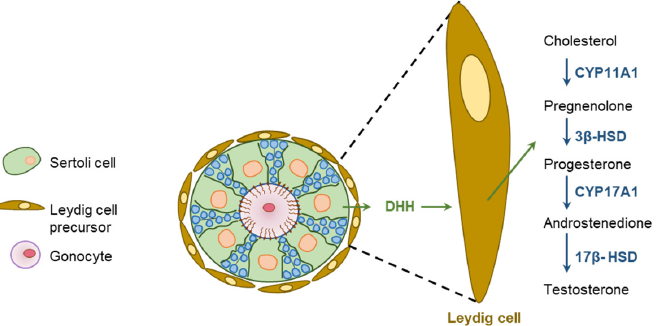
Figure 10. Hedgehog regulation of testicular functions. Sertoli cells (SCs) express DHH and the downstream HH signaling molecules are expressed in the Leydig cells (LCs). DHH secreted from the SCs act of LCs to induce proliferation and differentiation. In response to DHH signaling, LCs initiate steroidogenesis and secrete testosterone.